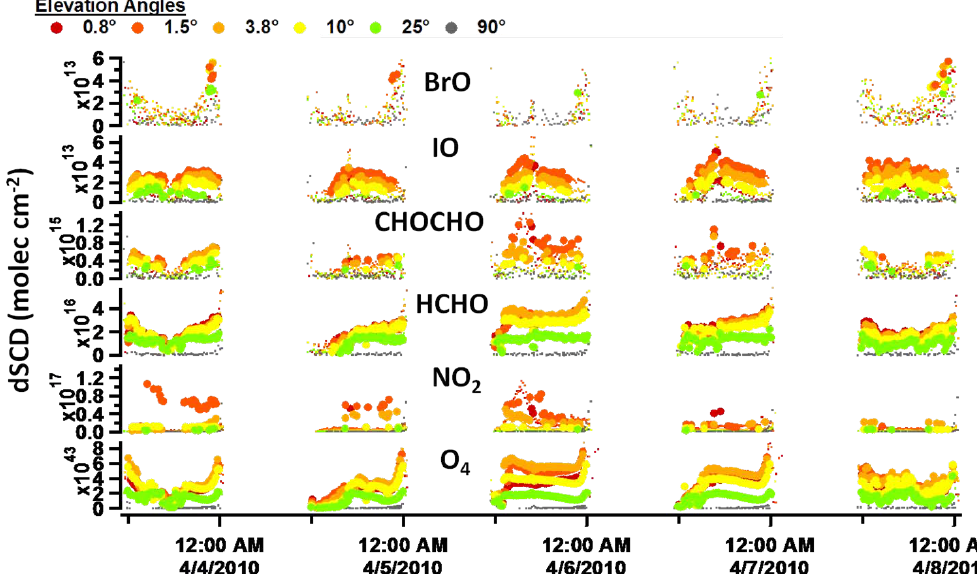
Fig. 9. Time series of the dSCDs for BrO, IO, CHOCHO, HCHO, NO 2 , and O 4 between 3 April and 8 April 2010 (times are in UTC). This plot is for viewing directions overlooking the bay area.The large circles for each elevation angle represent statistically significant measurements, while the small dots are measurements that do not meet the significance criteria. The average fit errors from the WinDOAS analysis for these elevation angles were 9.8 × 10 12 molec cm − 2 , 2.6 × 10 12 molec cm − 2 , 1.2 × 10 14 molec cm − 2 , 1.9 × 10 15 molec cm − 2 , and 1.6 × 10 14 molec cm − 2 for BrO, IO, CHOCHO, HCHO, and NO 2 , respectively.